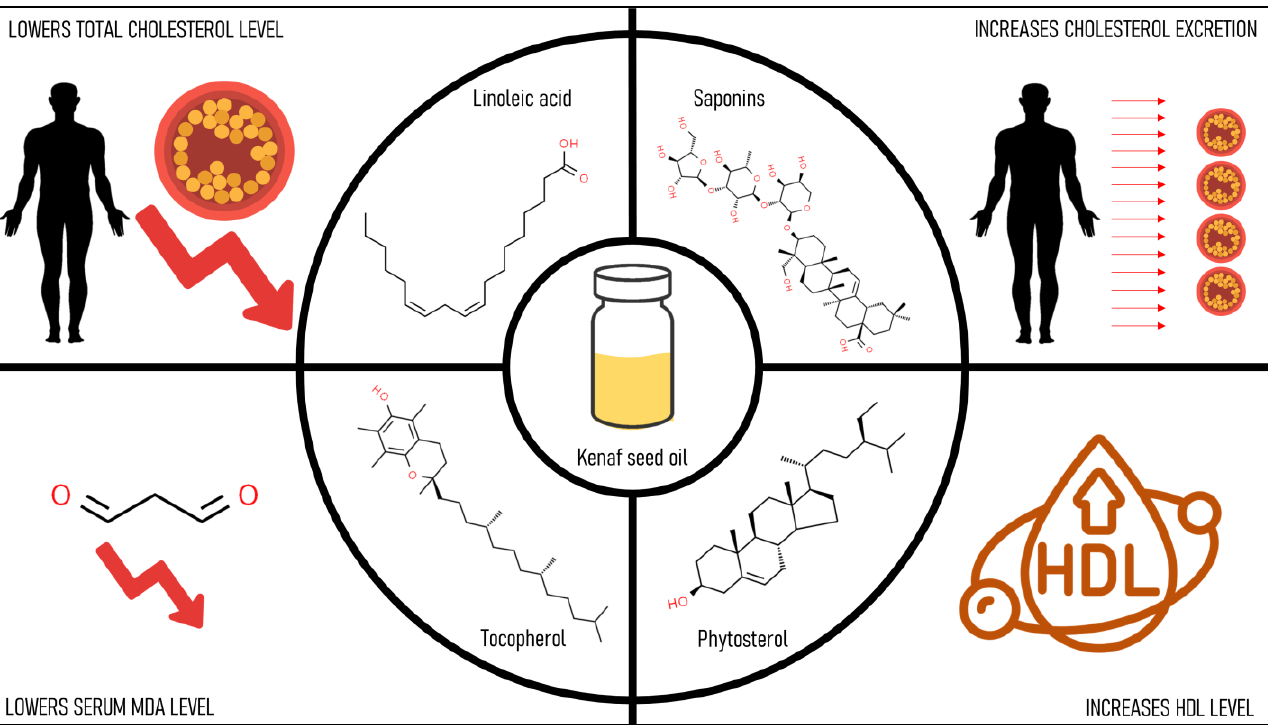
Figure 6. Graphical illustration of kenaf seed oil mechanism in addressing hypercholesterolemia conditions.